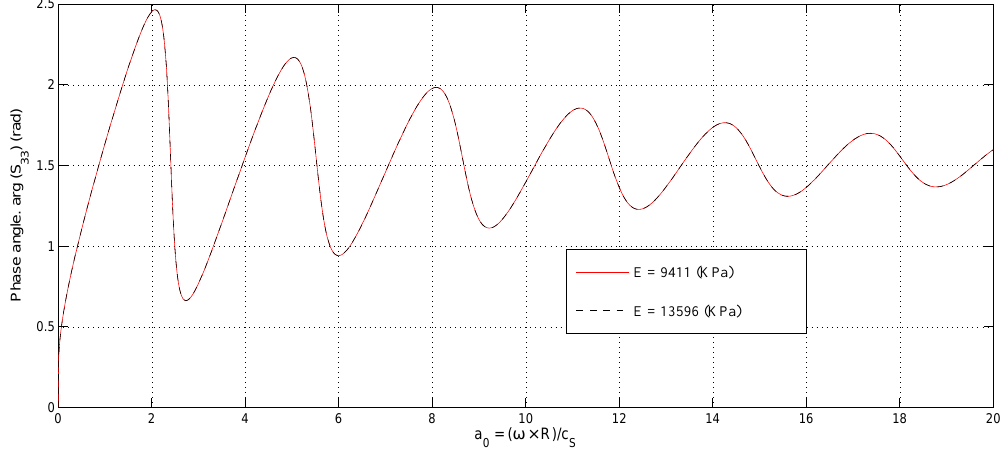
Figure 10. Phase angle of an infinite cylinder due to dynamic vertical load in the axial direction for different values of Young’s modulus E = 9411 KPa and E = 13596 KPa when the loss factor η = 0.1 and ν = 0.495 × 10 3